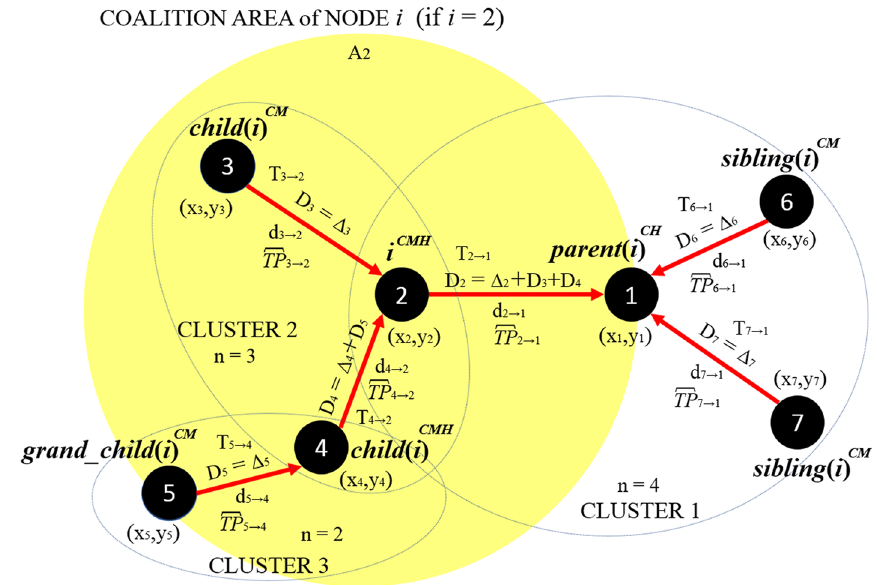
Fig. 2 Parameters of our proposed